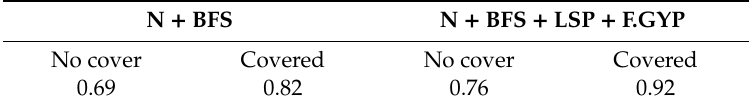
Table 9. E ff ect of covering precast molds on the minimum cracking